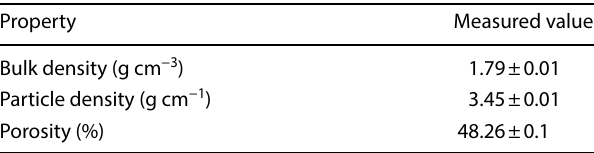
Table 4 Physical characterisation results of acid washed copper smelter slag Property